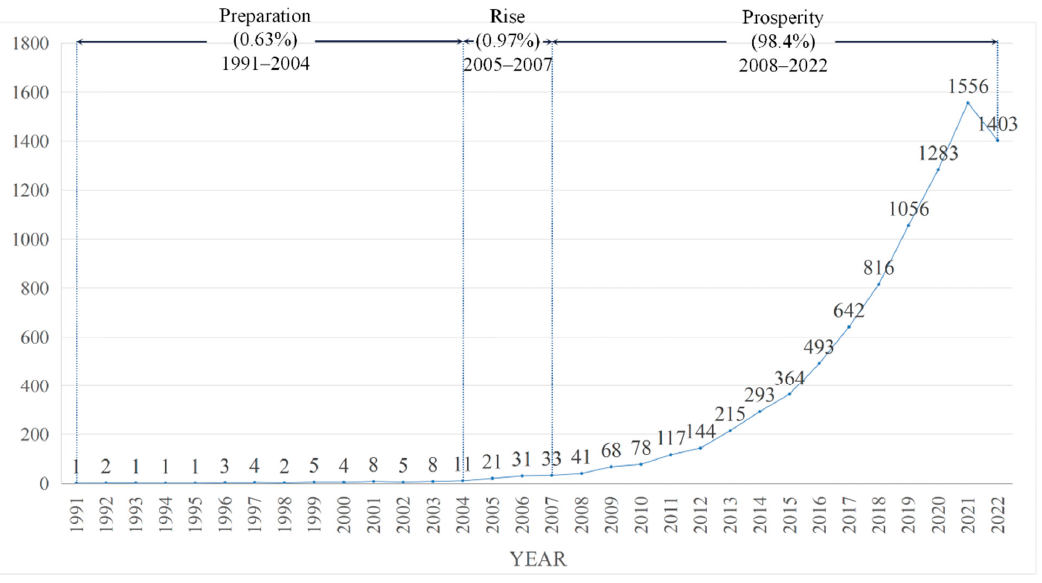
Figure 2. Distribution of annual publication outputs in the UES field from 1991 to 2022.